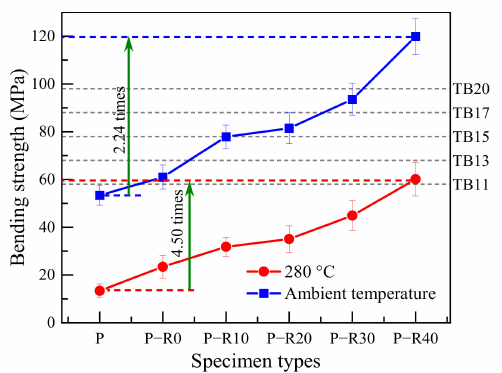
Figure 3. Bending strength of the control and modified poplar wood specimens at room temperature and 280 ◦ C. P—control; P-R0, P-R10, P-R20, P-R30, and P-R40—BPF specimens with 0, 10, 20, 30, and 40% compression ratios,